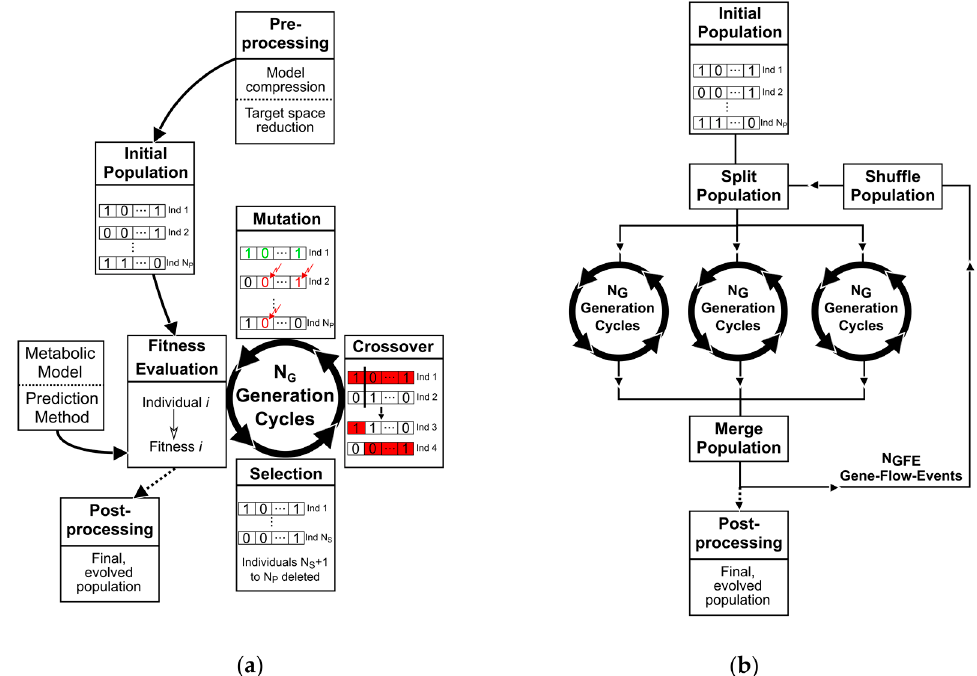
Figure 1. ( a ) Scheme of a basic GA; and ( b ) illustration of the parallelization method.